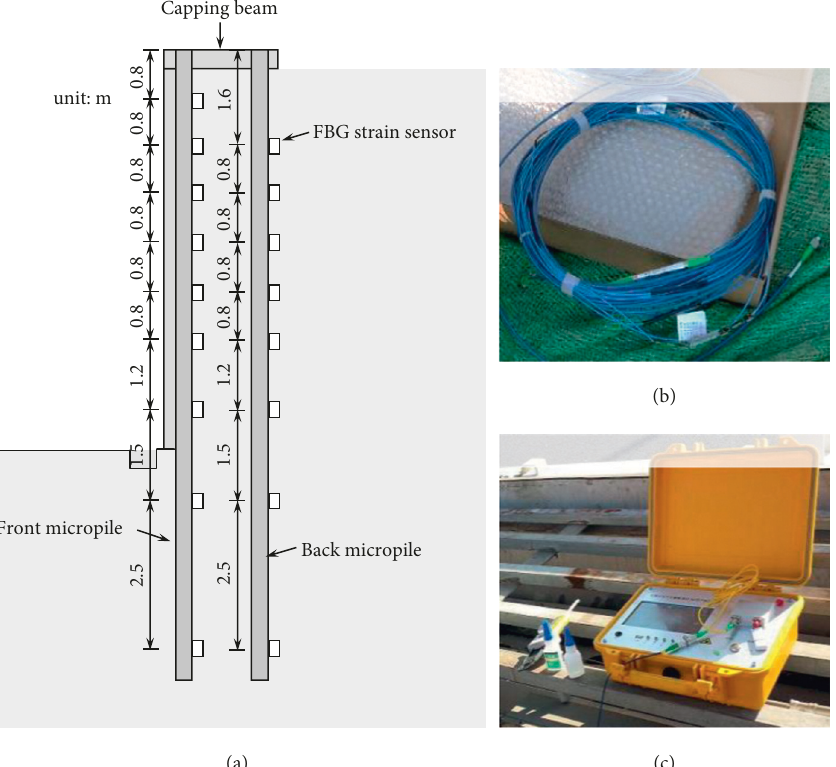
Figure 5: Micropile sensors layout plan and testing equipment. (a) Experimental setup of micropile. (b) FBG strain sensor. (c) FBG signal demodulator.